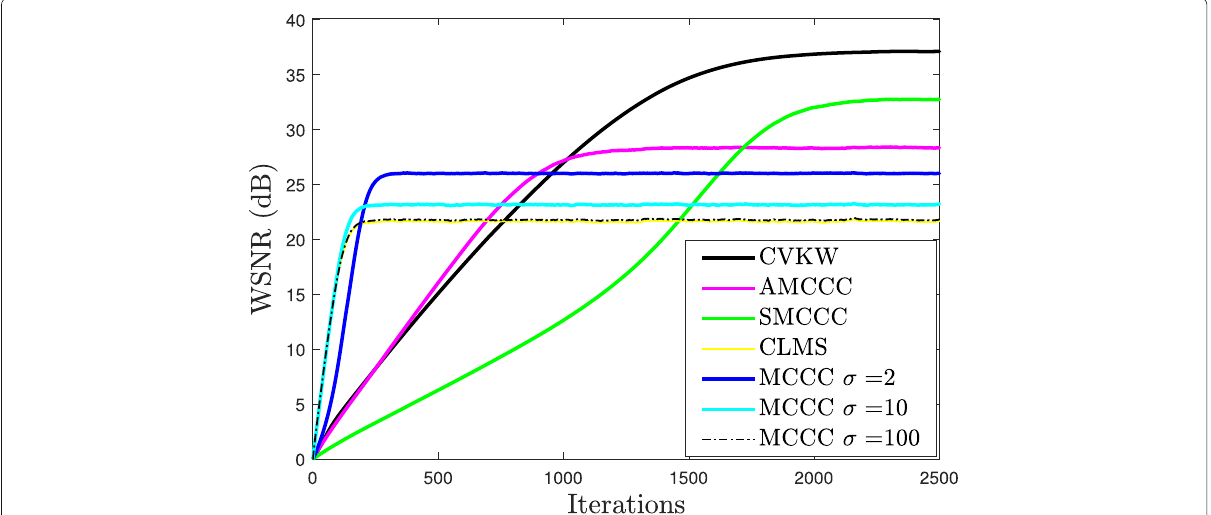
Fig. 2 Performance comparison among several methods in terms of WSNR as a function of the number of iterations for α =1.5 and GSNR = 20